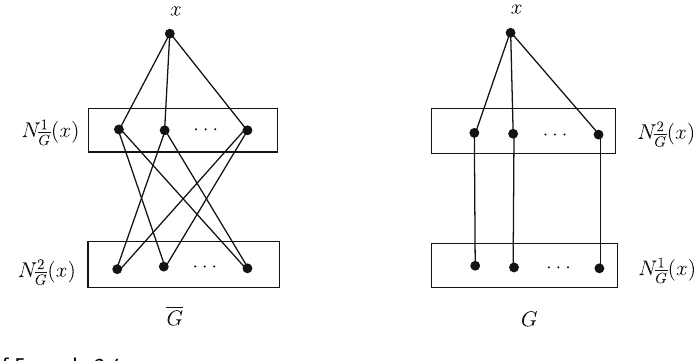
Figure 2: The graph of Example